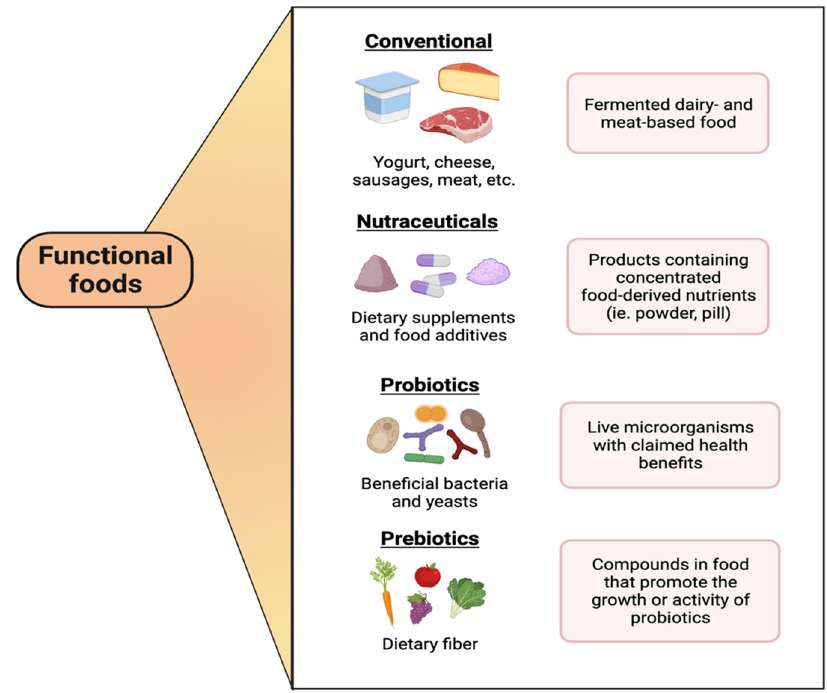
Figure 1. Main types and components of functional foods. This figure was created with biorender.com (accessed date: 26 April 2022).